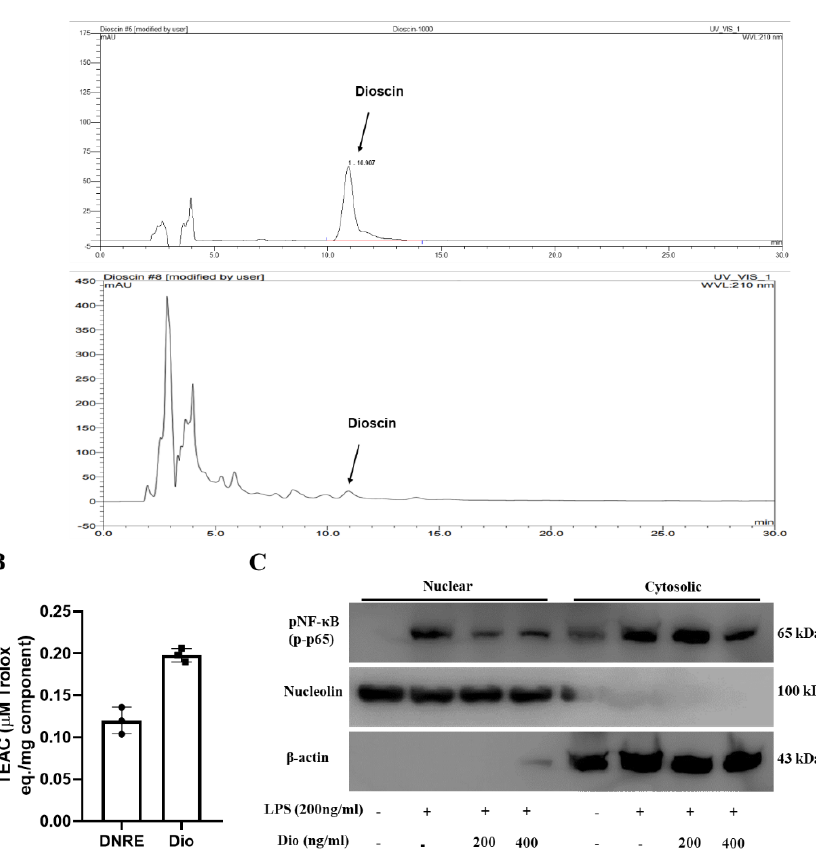
Figure 4. HPLC screening was conducted to identify the presence of and quantify dioscin in DNRE. ( A ) Representative chromatogram showing retention time and area of a standard steroidal saponin dioscin ( top ) and dioscin in DNRE ( bottom ). ( B ) The antioxidative capacity of dioscin (Dio) was measured using ABTS assay; an equimolar amount of DNRE and Dio was used, and the spectropho- tometric measurements are expressed as µ M of Trolox per mg of DNRE or Dio. ( C ) Nuclear and cytosolic fractions were isolated from LPS-activated BV-2 microglial cells pre-treated with or without different doses of dioscin and probed with anti-phosphorylated NF- κ B